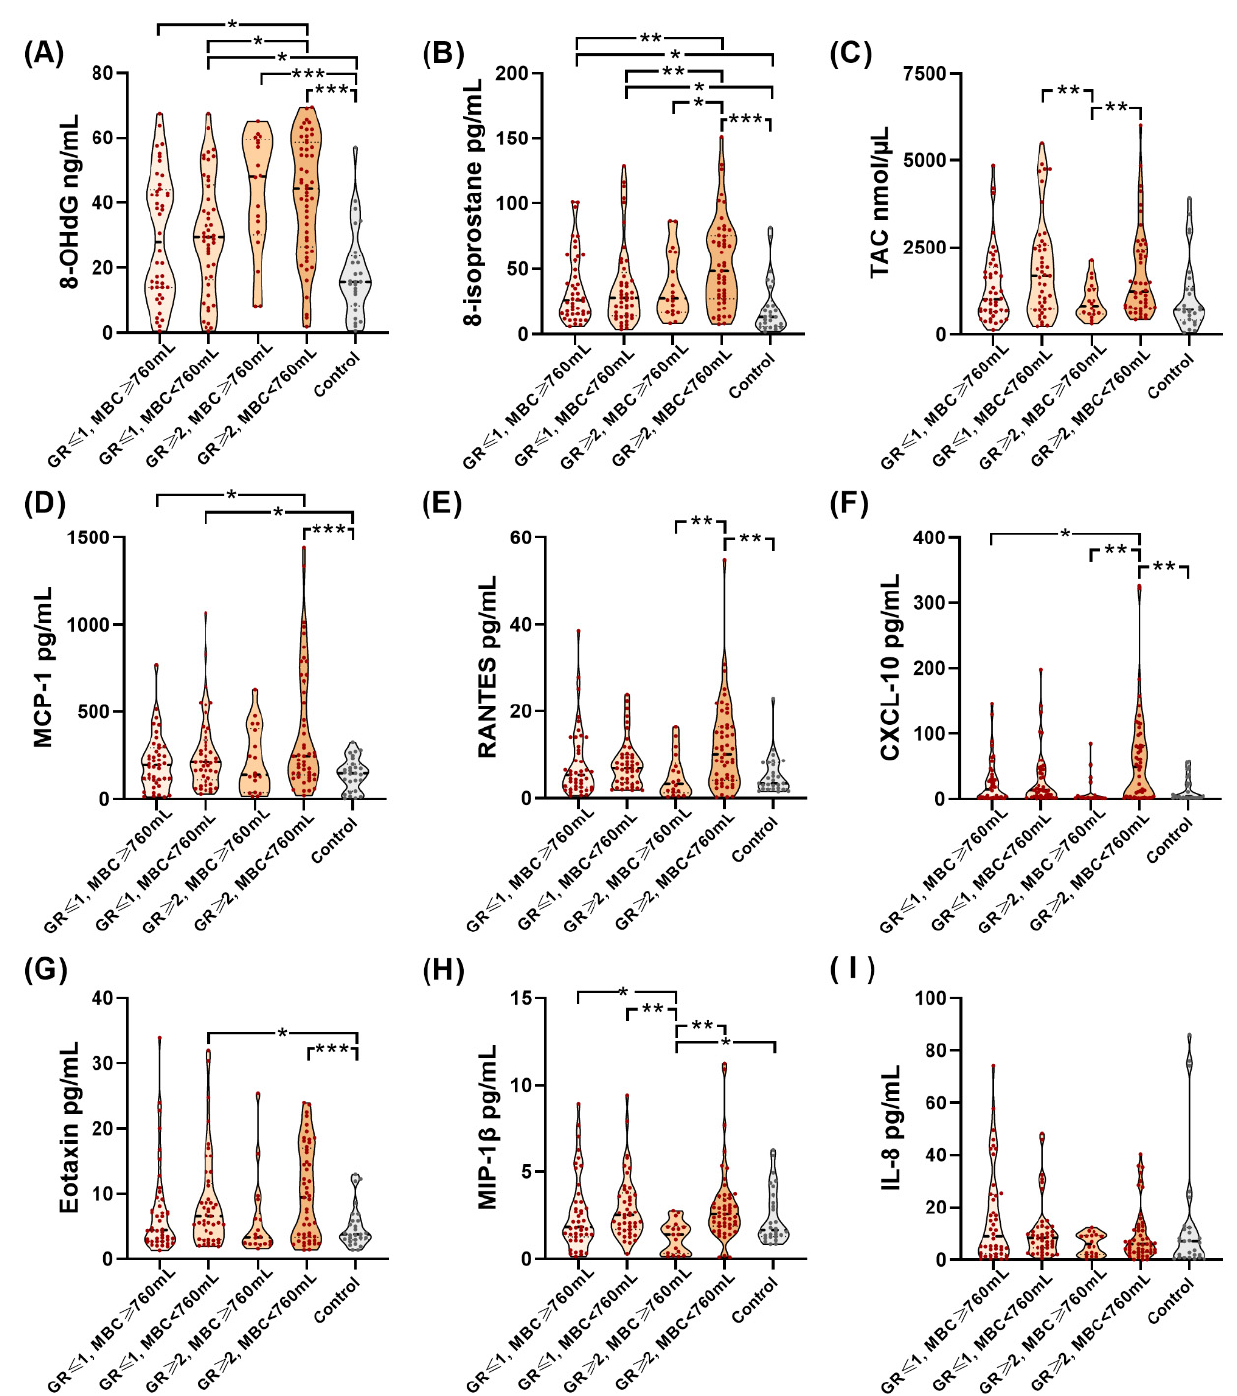
Figure 1. Violin plots of levels of urine biomarkers among different subgroups of patients with IC/BPS and control patients. Urine levels of ( A ) 8-OhdG, ( B ) 8-isoprostane, ( C ) TAC, ( D ) MCP-1, ( E ) RANTES, ( F ) CXCL-10, ( G ) Eotaxin, and ( H ) MIP-1 β , but not ( I ) IL-8 were significantly different among different subgroups of patients with IC/BPS and control patients. *: p -value < 0.05, **: p -value < 0.01, ***: p -value < 0.001.